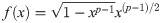
The function f(x)=1-xp-1x(p-1)/2, 0 < x ≤ 1, for selected powers 1 < p ≤ 3.